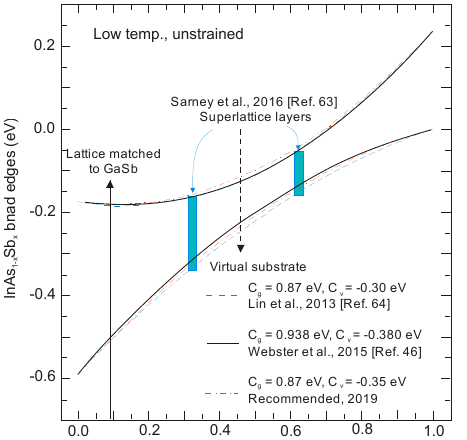
Figure 9. InAs 1–x Sb x VB and CB edges and their alignment assuming that x = 0 for InAs and x = 1 for InSb. As noted by the dashed arrow, longer wavelengths than InAsSb can be reached with T2SLs grown on a virtual substrate InA 0.54 Sb 0.46 (after [20,63]). Bandgap bowing, C g , has been distributed to the VB, C v , and CB as shown according to the references [49,64]. The dash-dot curves represent the suggested bandgap and VB bowing equal 0.87 and − 0.35 eV, respectively. The solid arrow points the composition of InA 0.91 Sb 0.09 lattice-matched to GaSb substrates.